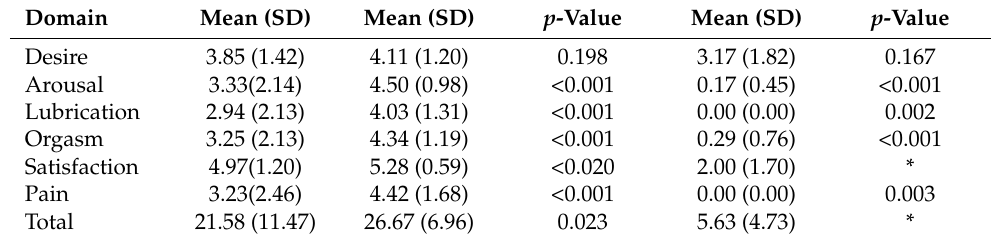
Table 2. Results of the Female Sexual Function Index.